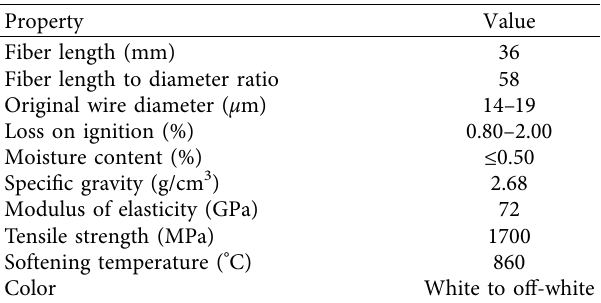
Figure 1: Particle size distribution of the aggregates. Table 1: ARGF